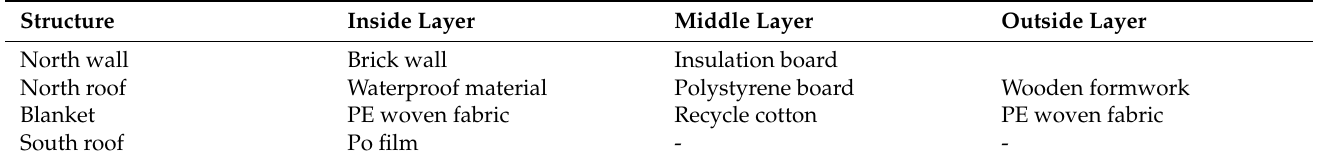
Table 3. Structural layers used in the